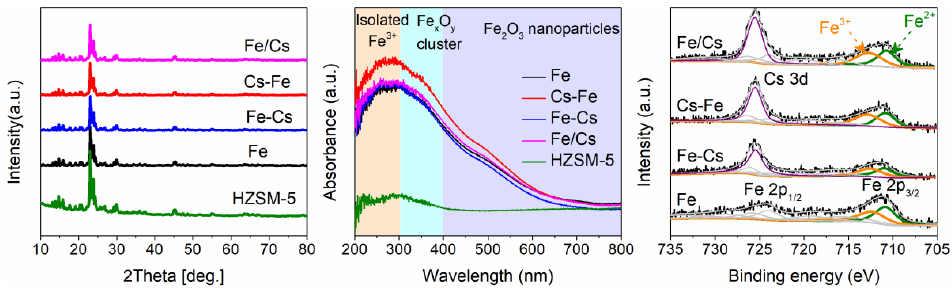
Figure 6. Properties of Fe-HZSM-5, Cs-Fe-HZSM-5, Fe-Cs-HZSM-5 and Fe/Cs-HZSM-5 catalysts analyzed by ( a ) XRD, ( b ) UV–Vis and ( c ) XPS. Table 1. Composition of Fe-HZSM-5, Cs-Fe-HZSM-5, Fe-Cs-HZSM-5 and Fe/Cs-HZSM-5 catalysts determined by ICP, XRF and XPS.